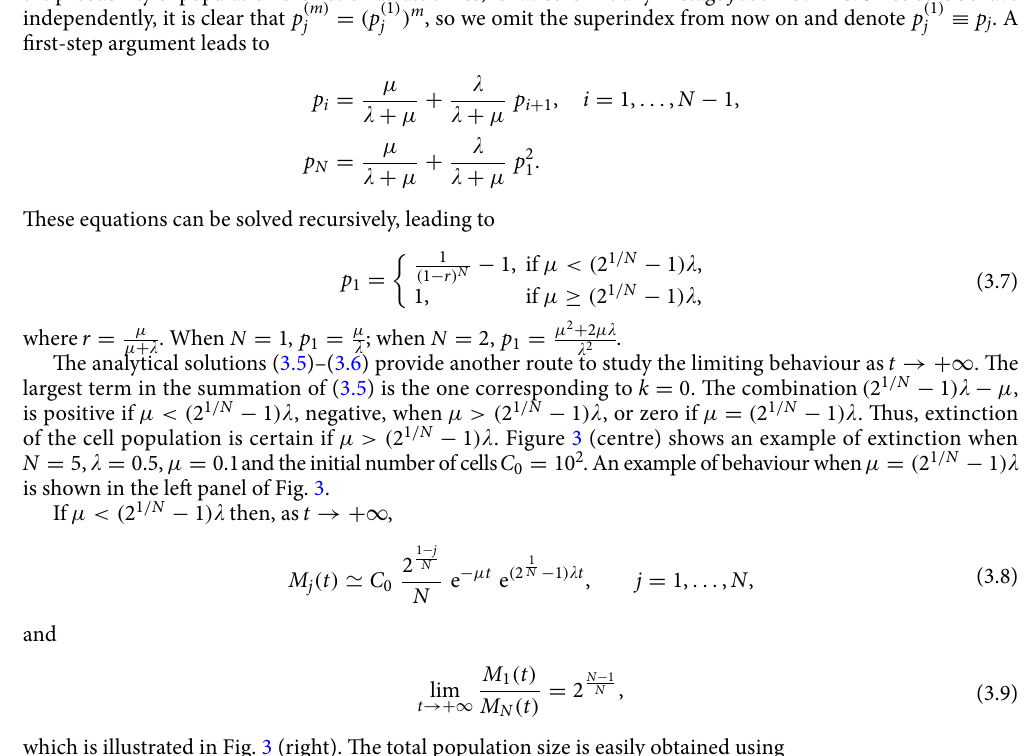
Figure 3. Limiting behaviour when t and death rates, (cid:31) and µ , have units of inverse time, t − 1 . Left: Parameters: N The population of cells in stage j levels out to 2 (cid:31) 0.5 , µ 0.1 . The population of cells at any stage becomes extinct at late times. Right: Parameters: N = = (cid:31) 0.8 , µ 0.1 . The populations grow according to (3.11) and the relation between M 1 and M 5 given by = = Eq. (3.9) is satisfied. For example, at t